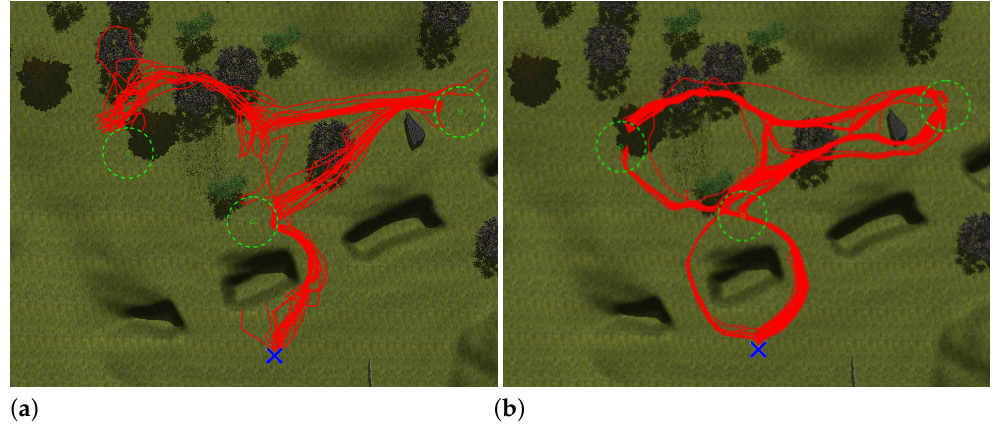
Figure 24. Paths followed by Andabata with the reactive ( a ) and the Actor NN ( b ) approaches. Table 4. Success ratio for reaching three consecutive goals along 50 simulated